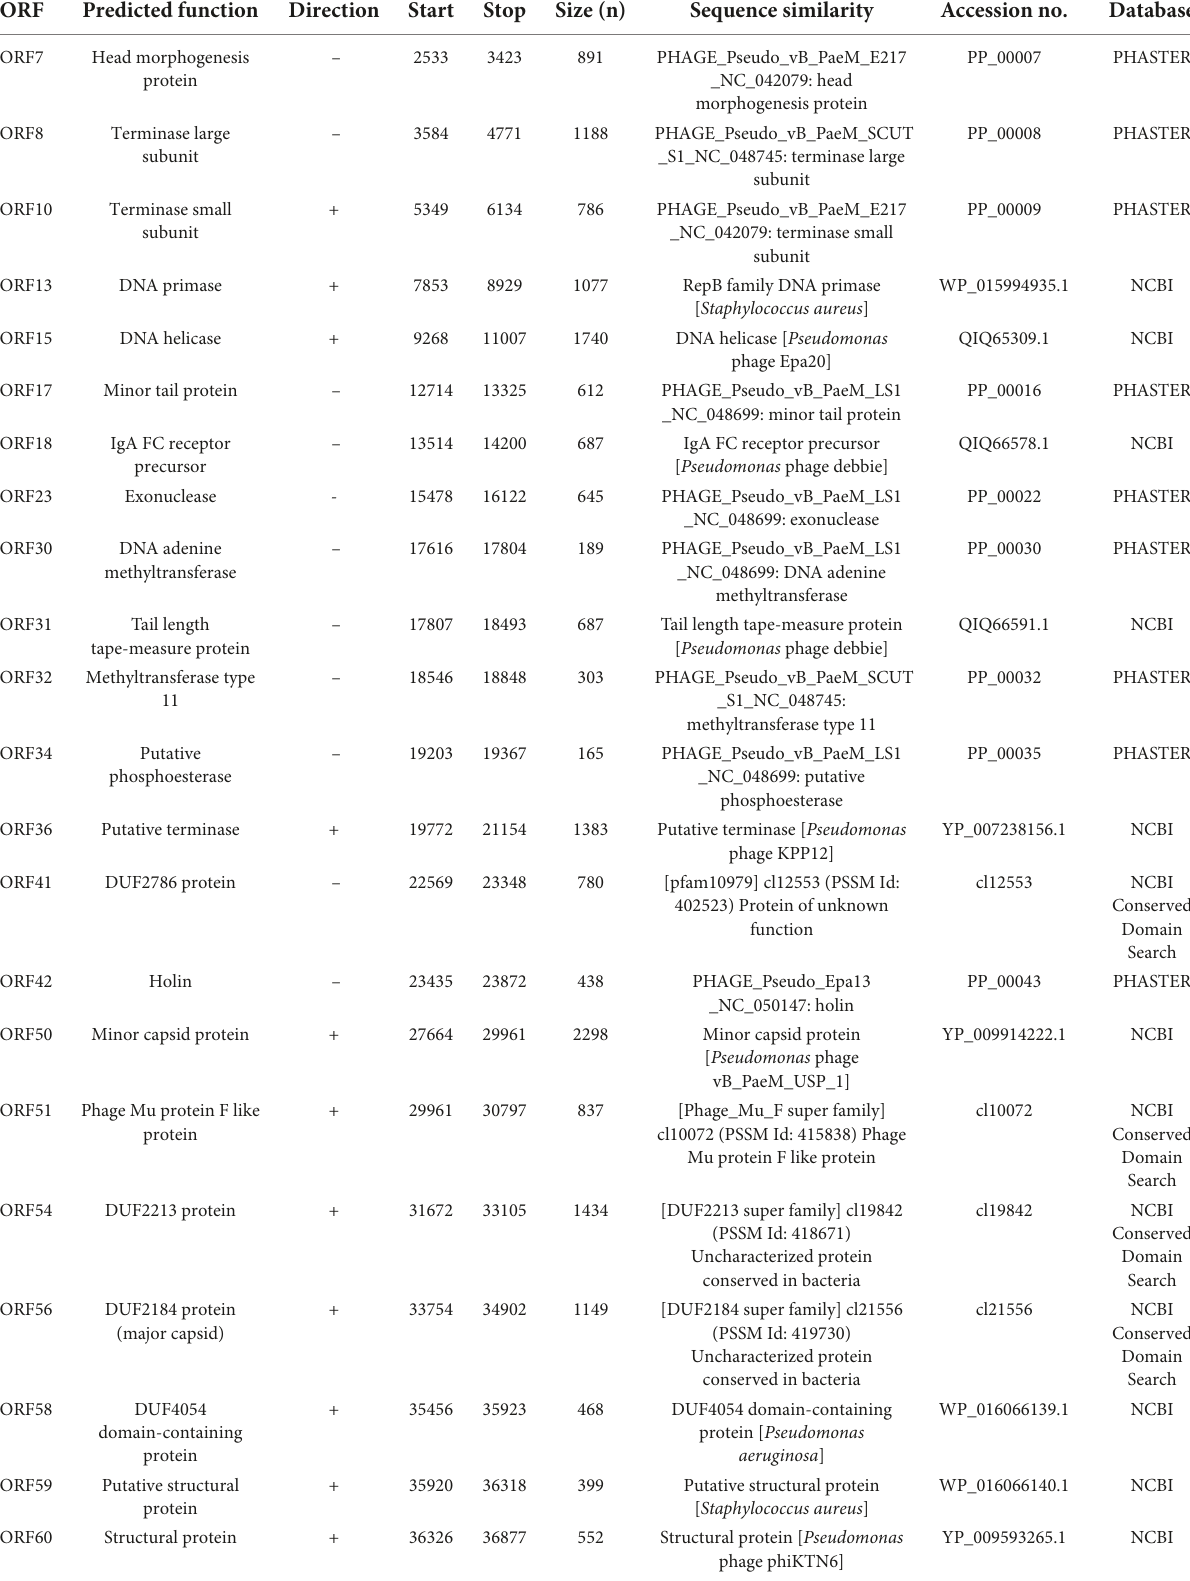
TABLE 2 List of functionally annotated proteins from ORFs in the genome of phage JJ01. ORF Predicted